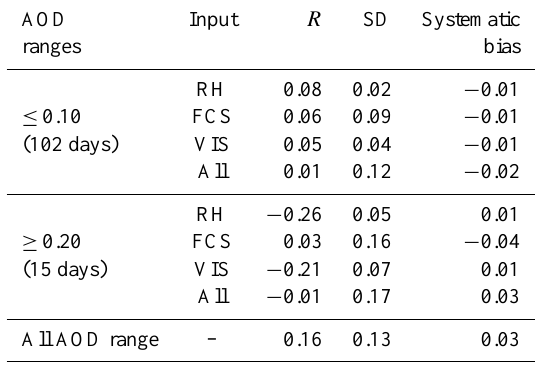
Table 2. Statistics of the difference between non-perturbed and per- turbed ANN AOD estimates (AOD − (AOD ± δ )): Pearson correla- tion coefficient ( R ) between the differences and ANN AOD values, standard deviation (SD) and median of the difference time series (systematic bias). “All” represents the error estimation considering the uncertainties of all parameters together (VIS ± 25%, FCS ± 5% and RH ± 2%).